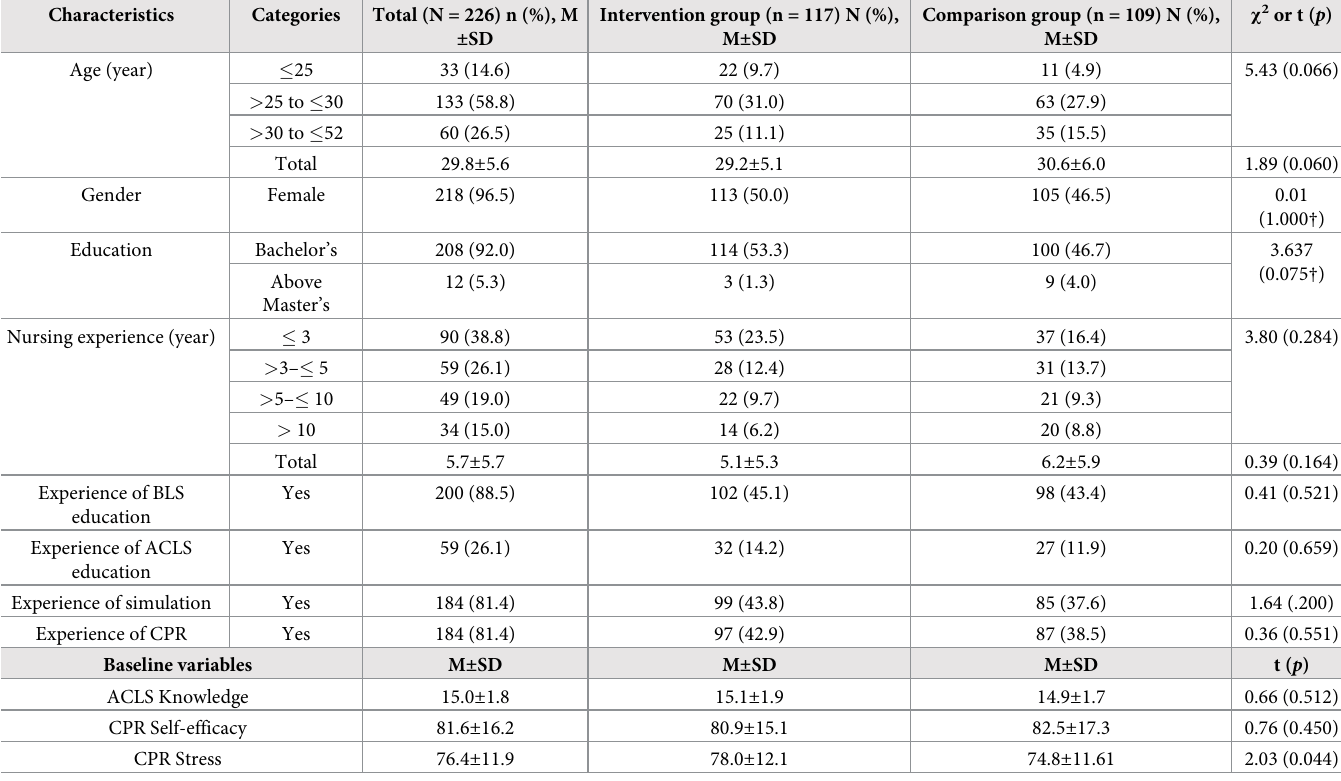
Table 1. Baseline characteristics and pretest outcomes of participants (N =